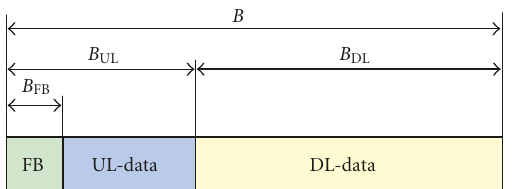
Figure 1: Partitioning of the available bandwidth into a downlink band and an uplink band, where the latter accommodates also a band reserved for feedback. Note that the gap in frequency between the uplink and the downlink band is not shown in this